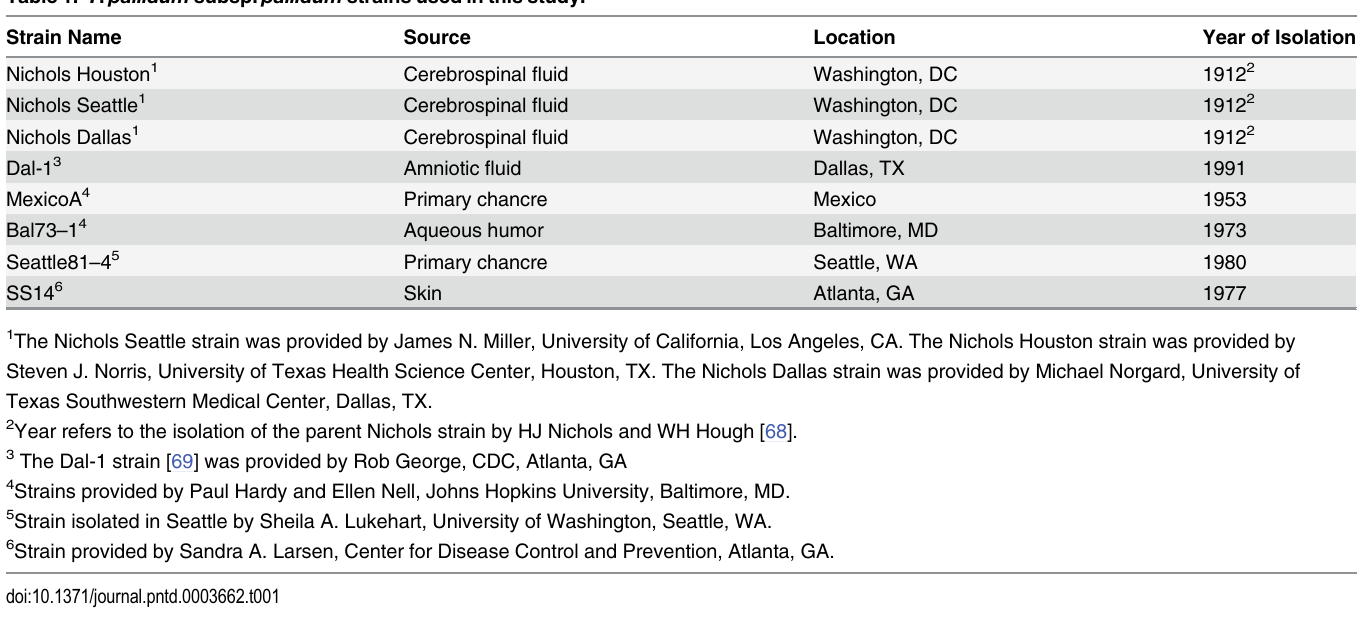
signed to amplify the complete or partial tp0136 ORF from the Nichols Seattle and Nichols Houston strains for cloning into the pEXP-5-CT expression vector (Table 2) for producing re- combinant proteins. In this case, sense primers annealing to the 5 ’ -terminal region of tp0136 gene were designed to exclude the sequence encoding the putative signal peptide (aa 1 – 32, de- termined using the SignalP4.1 Server, http://www.cbs.dtu.dk/services/SignalP/). For compara- tive sequence analysis, tp0136 ORF was amplified in 50 μ l final volume using approximately